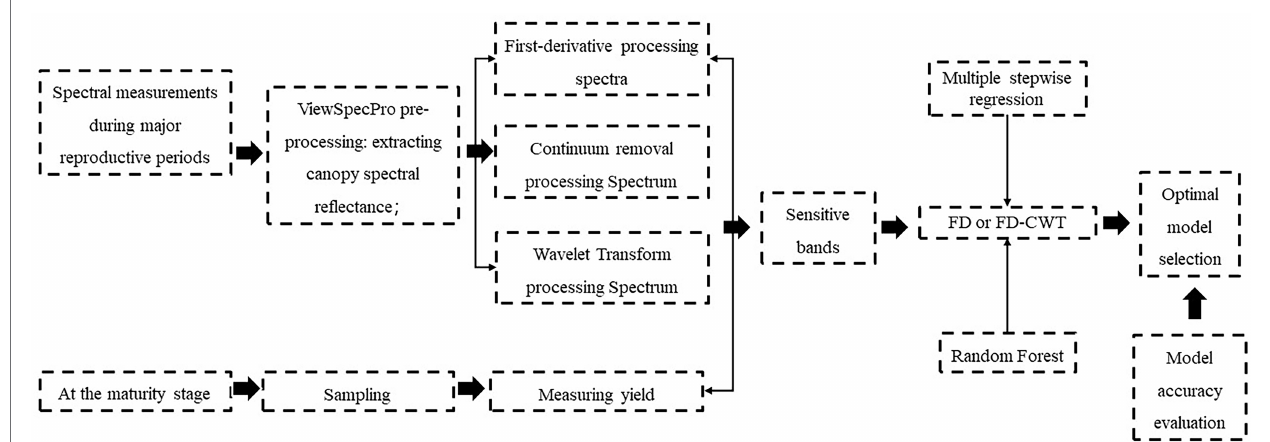
FIGURE 1 | A flowchart of the research